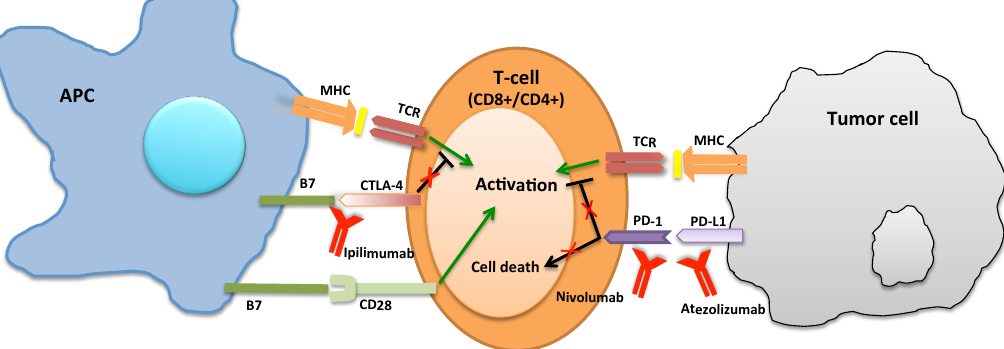
Figure 1. Anti CTLA-4 (such as Ipilimumab) increased the T-cell activation by binding the CTLA-4 receptor. Anti PD-1 (such as Nivolumab) and anti PD-L1 (such as Atezolizumab) allow the T-cell to identify the tumor cells binding to PD-1, or PD-L1,